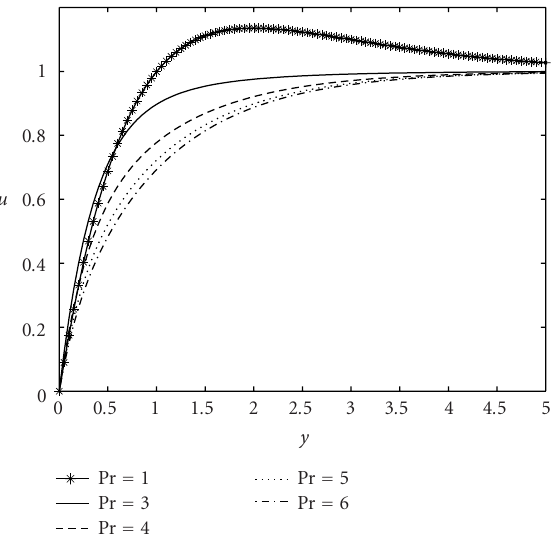
Figure 4.1. Main flow velocity u for Gr = 5 . 0, S = 1 . 0, ω = 10, z = 0 . 2, t = 0 . 2, (cid:2) = 0 . 2.